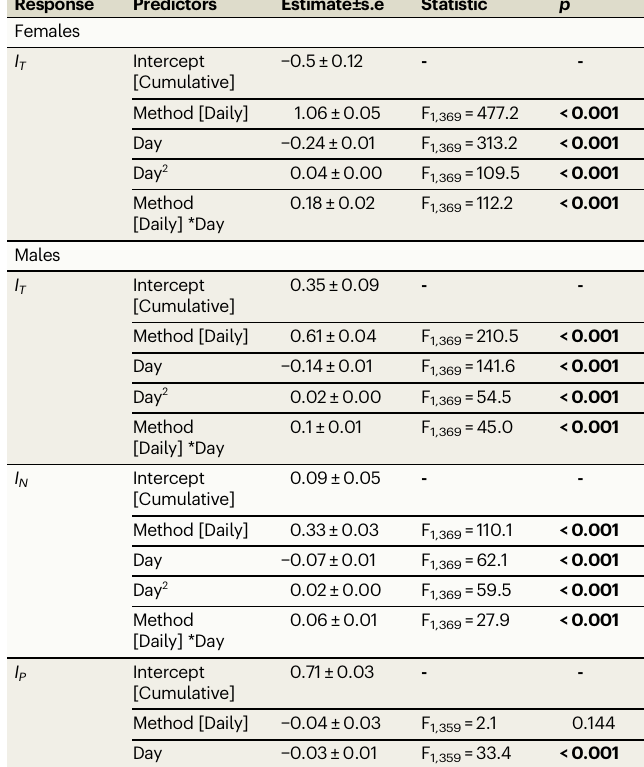
Table 2 | Temporal patterns in the opportunity for total selection ( I T ) and its components ( I N , I P ), across successive days (Day) calculated using two different methods (i.e. cumulative or daily instantaneous reproductive success) across multiple replicate groups of red junglefowl ( Gallus gallus